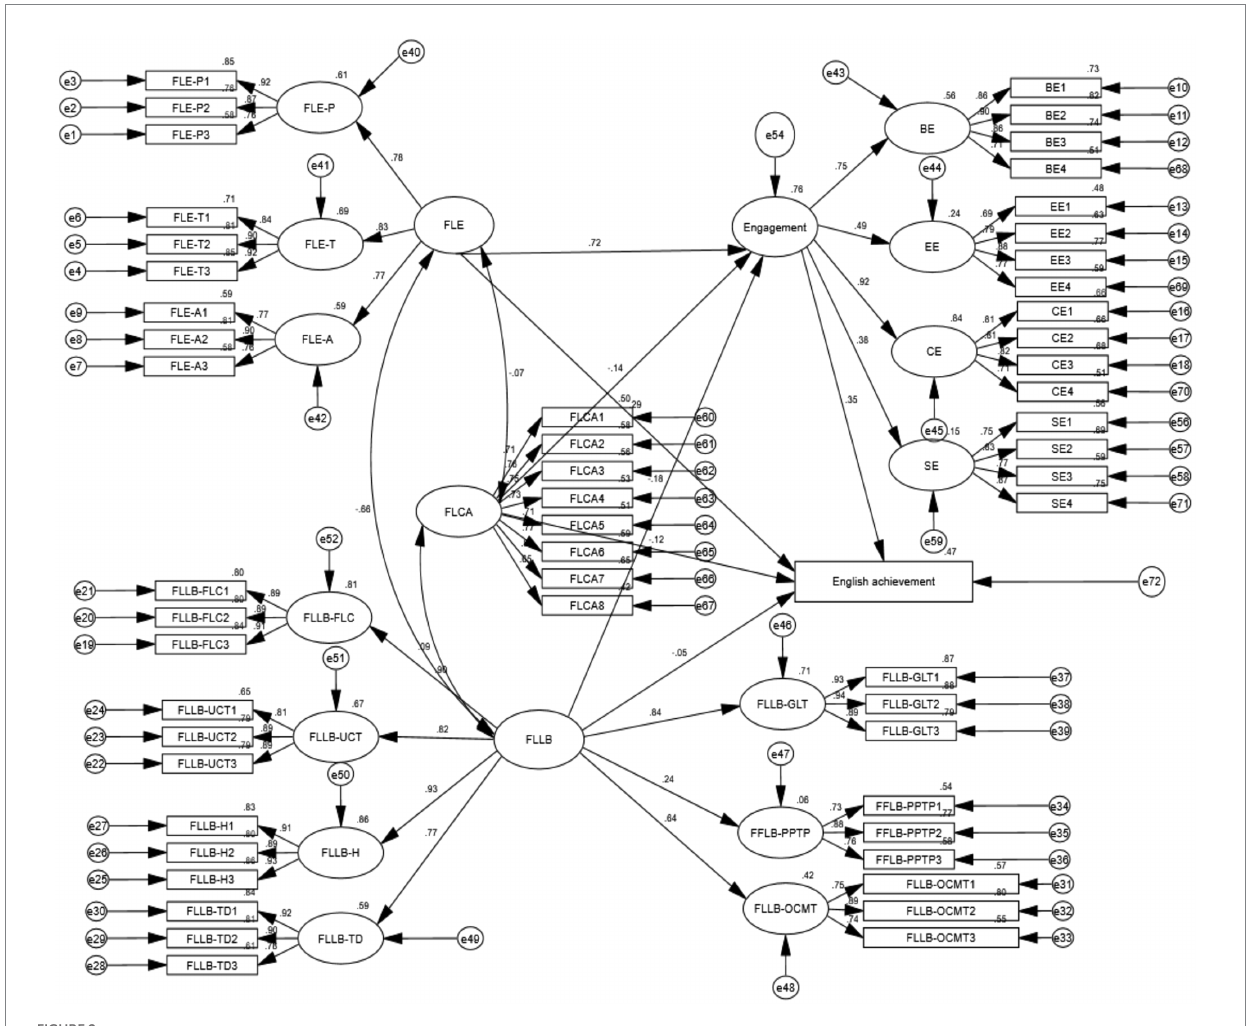
FIGURE 2 The final model of emotions, engagement, and English achievement.